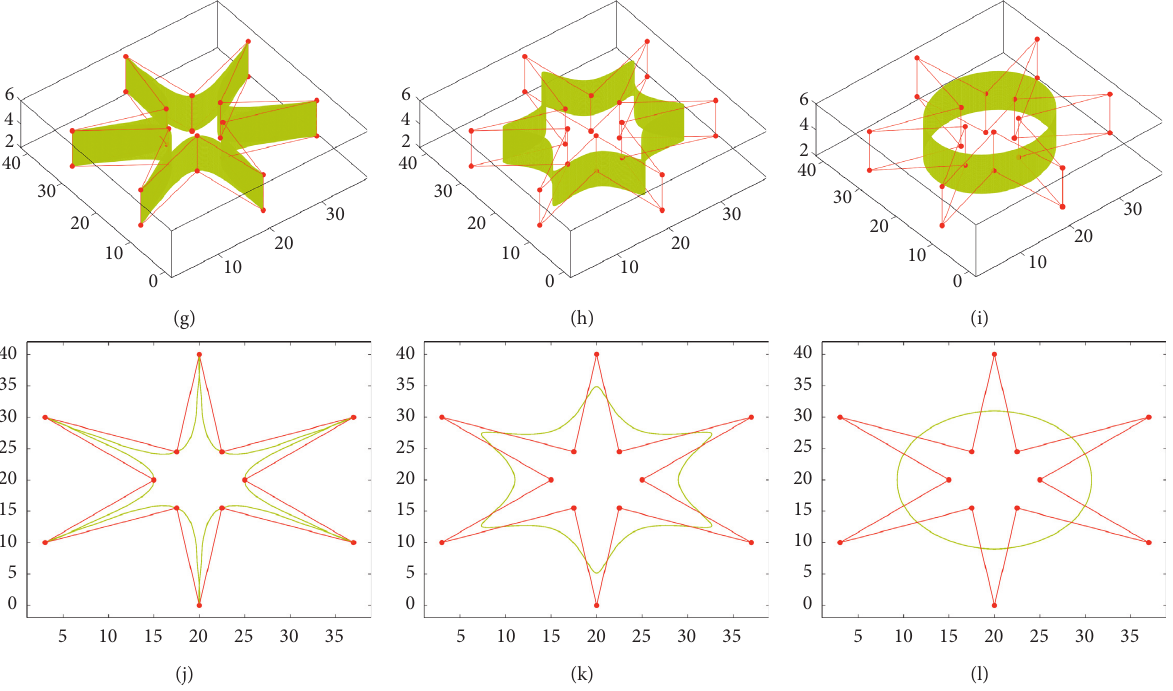
a 3 . (d–f) The mirror images of the parts inside the blue